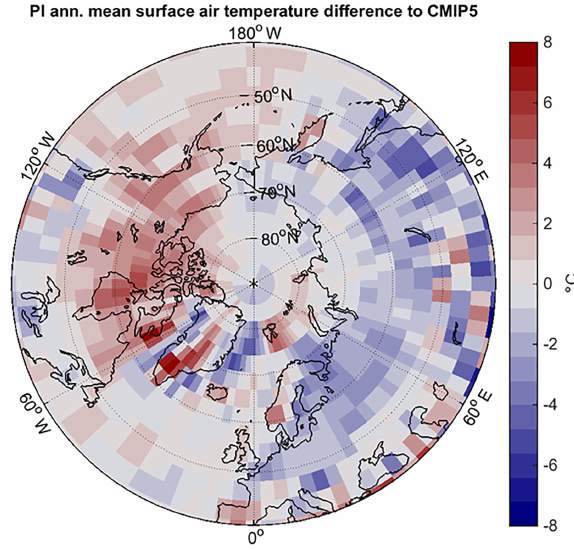
Figure A2. Difference in simulated annual mean surface air tem- perature by MPI-ESM1.2T31_PI compared to CMIP5 PI experi-